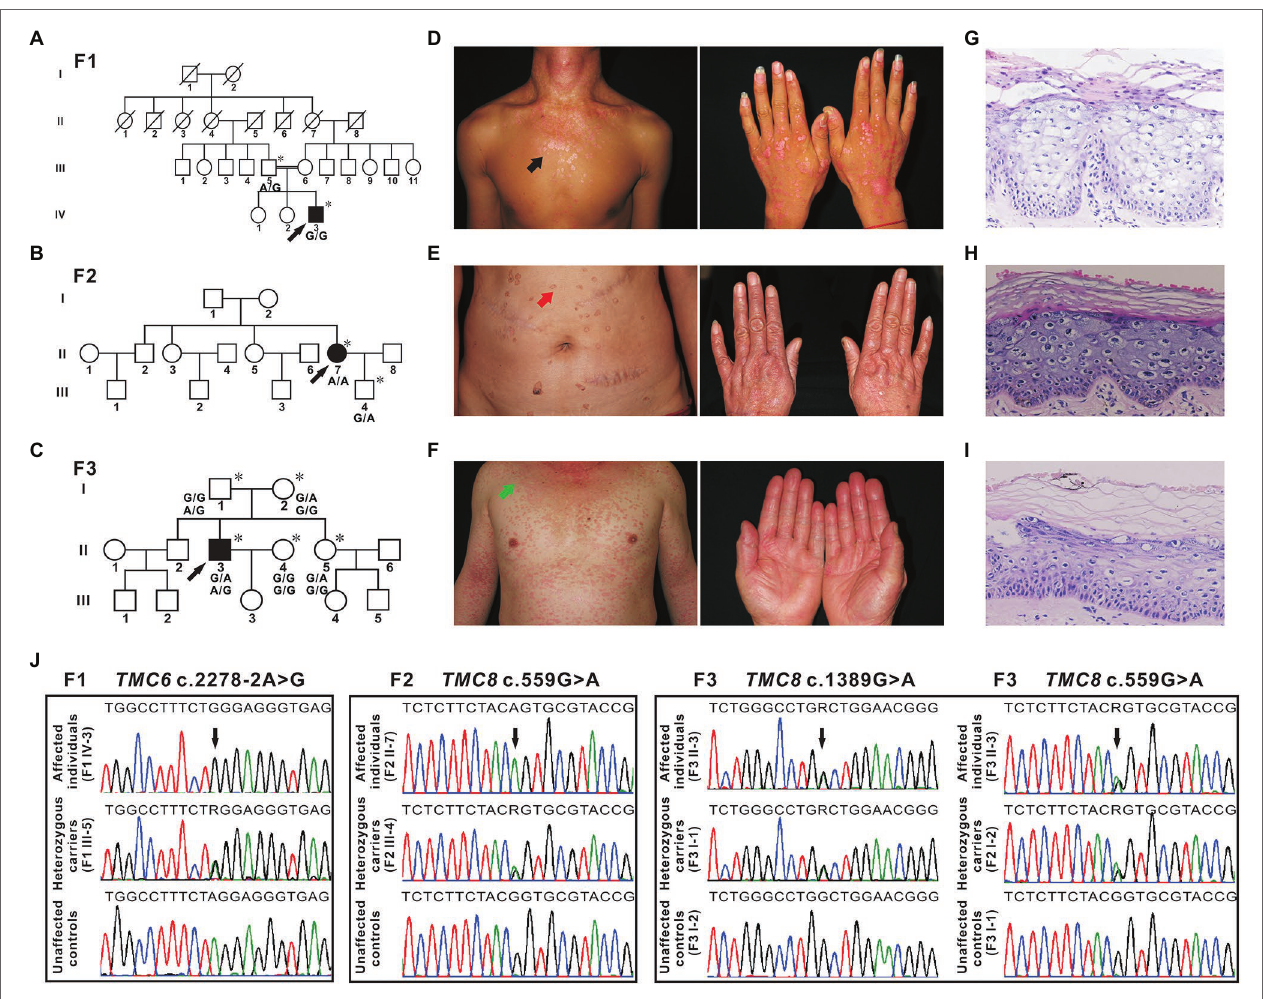
FIGURE 1 | Pedigrees, clinical characteristics, and detection of variants in three Chinese epidermodysplasia verruciformis (EV) families. (A–C) Pedigrees of three family members affected by EV (F1, F2, and F3). The squares, circles, blackened, and open symbols indicate males, females, and affected and unaffected individuals, respectively. The arrows indicate the probands, and the asterisks denote the individuals available for genotyping. (D) Reddish papules coalesced into flat plaques on the neck and chest of patient IV-3 (F1, black arrow). (E) Verrucous hyperkeratotic brownish macules on the abdomen of patient II-7 (F2, red arrow). (F) Pityriasis versicolour-like lesions on the neck, trunk, and extremities of patient II-3 (F3, green arrow). (G–I) Histopathology of affected skin from three probands [patient IV-3 from F1 (G) , patient II-7 from F2 (H) , and patient II-3 from F3 (I) ], hyper/parakeratosis, and large numbers of nests of koilocytes in the granular and spinous layers with a clear, light-blue pale cytoplasm. H&E (×200). (J) Sequencing chromatograms of affected individuals, heterozygous carriers of TMC6 , or TMC8 variants. Unaffected controls are also shown. The black arrows indicate the sites of the variants, and R (a degenerate base) indicates A and G